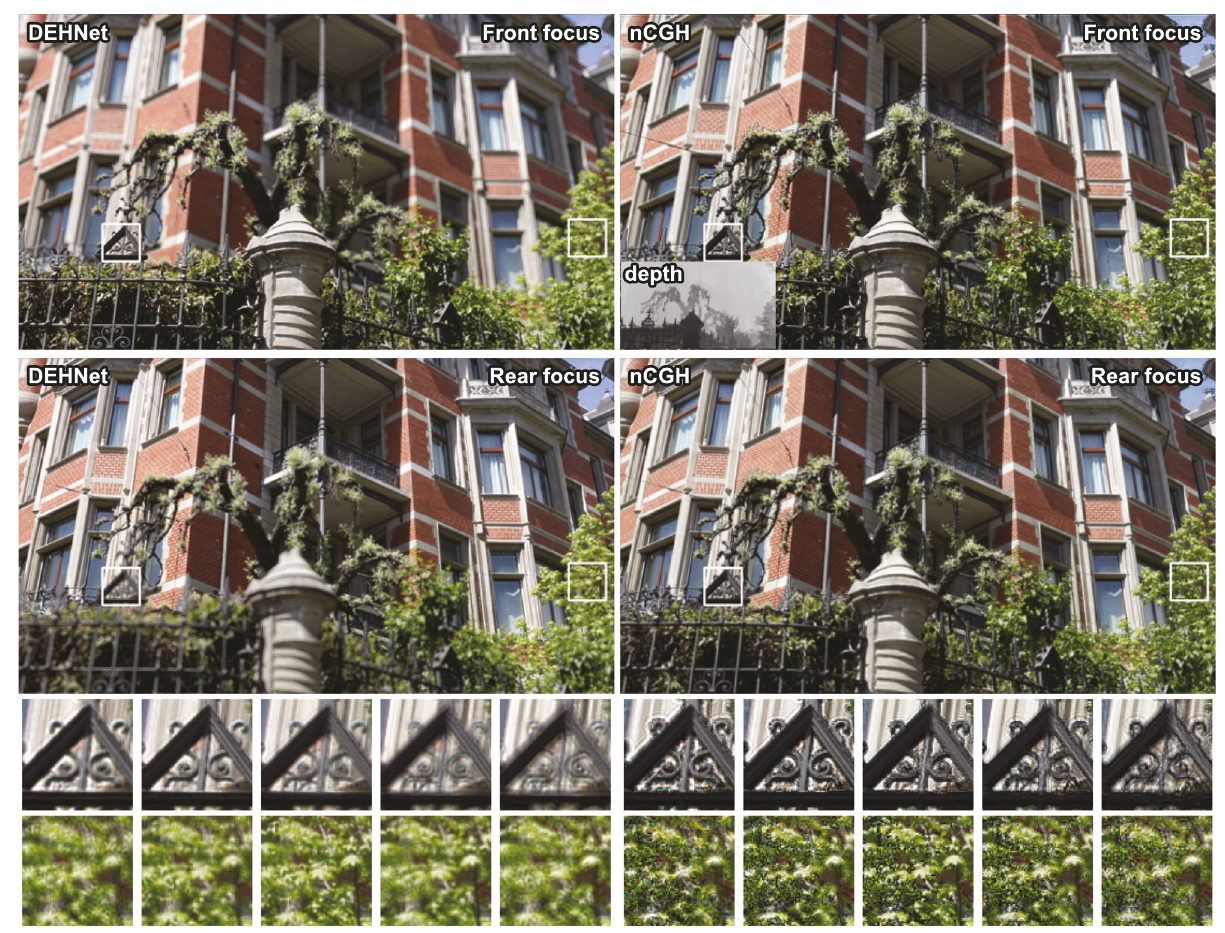
Fig. 6 | Simulation results obtained using a real-world RGB-D image. Using a real-world-captured image 56 , a DEH and an nCGH were synthesized and their intensities were simulated wherein the total image size was resized to 1280×720. The large images show the front- and rear-focused images, while the small images